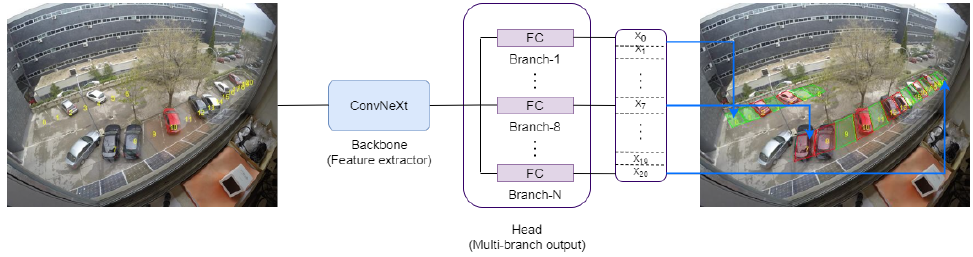
Figure 2. Input–Output system architecture. The backbone processes the color images acquired from the parking scene to compute a global feature map. The multi-branch output independently processes the common feature map, so each branch uses all the image information to estimate if a specific parking slot is